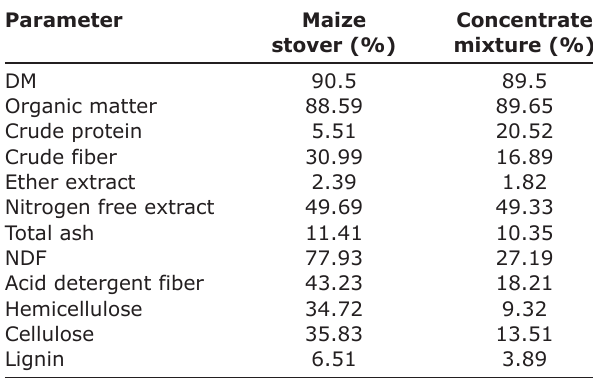
Table-2: Chemical composition (% DM basis) of experimental feeds and complete diets.